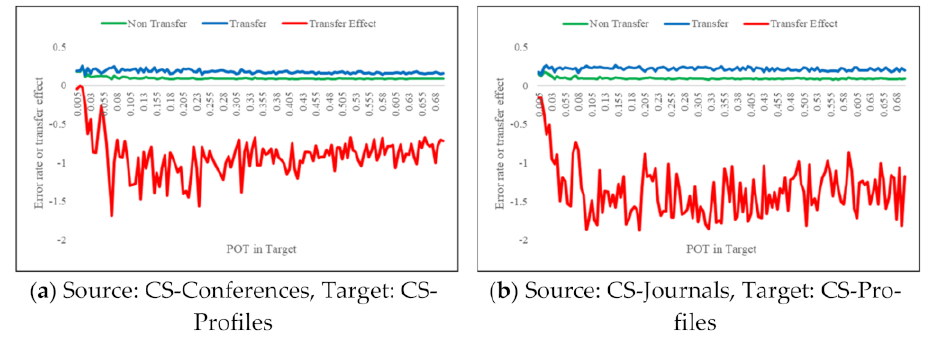
Figure 7. The relationship between the training set division and transfer effect in negative